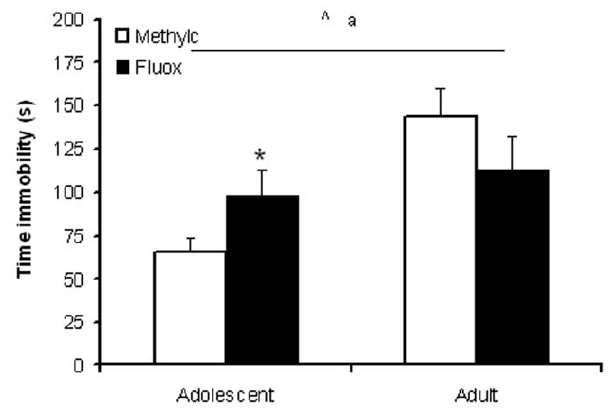
Figure 2. Effect of fluoxetine on exploratory behavior in adolescent and adult rats. Data are presented as mean 6 S.E.M. of distance moved within 60 min (n=10). 7 Days following chronic fluoxetine treatment (12 mg/kg) exploratory behavior in the open field was not affected in adolescent, nor adult, rats. a p , 0.05 main age effect.